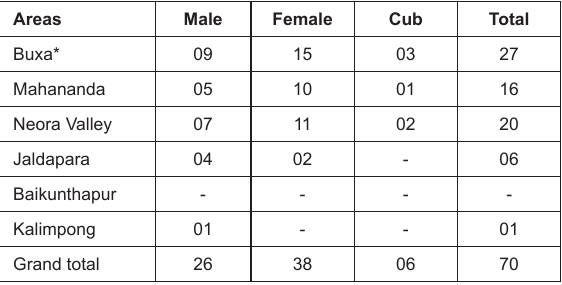
Table 5. Population composition of tiger in northern West Bengal during 2004 (Bhutia 2005; Anon. 2008a)